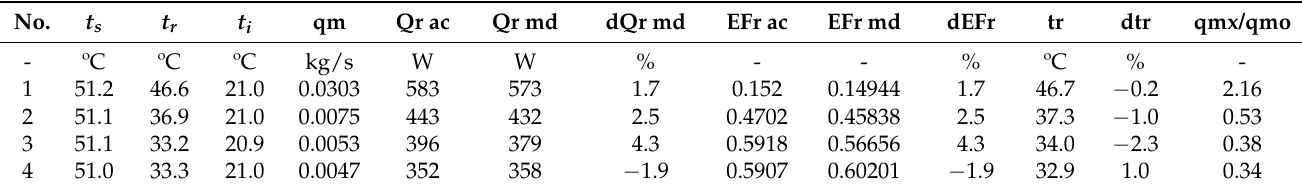
Table 5. The comparison between the measurement results and the simulation calculations Convector Radiator type-8RR , t s = 51.1 ◦